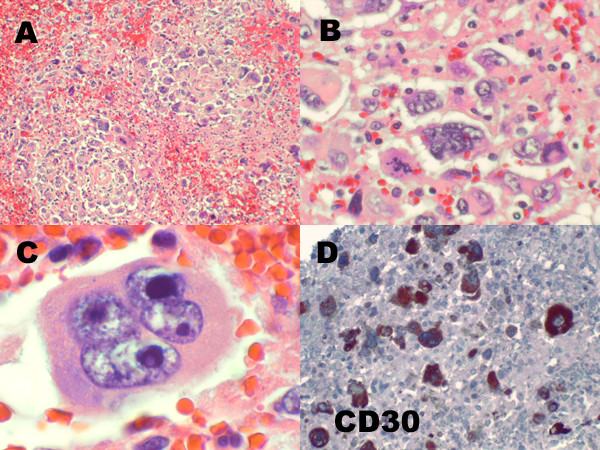
Spleen at autopsy. (A) Multiple tumor nodules efface the normal splenic architecture (hematoxylin and eosin, ×100). (B) The tumor nodules consist of clusters of numerous bizarre multinucleated tumor giant cells with irregular nuclei and coarse chromatin (hematoxylin and eosin, ×400). (C) Occasional classic Reed-Sternberg like tumor cells with macronucleoli are also present (hematoxylin and eosin, ×1000). (D) An immunostain for CD30 highlights the majority of the tumor giant cells (×100).